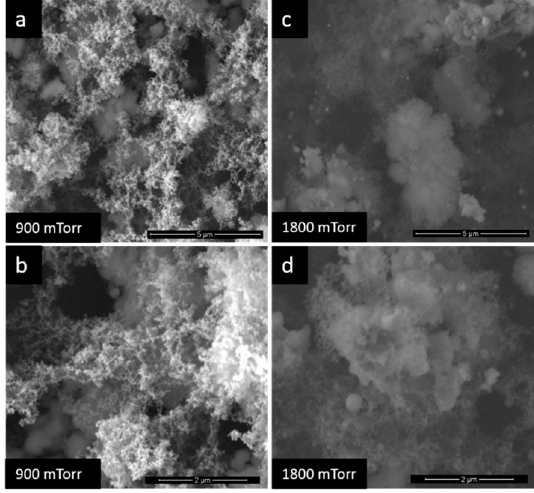
Figure 2. Scanning electron microscopy (SEM) images of TiO 2 films at ( a ) and ( b ) − 100 mTorr, ( c ) and ( d ) − 300 mTorr, ( e ) and ( f ) − 600 mTorr.